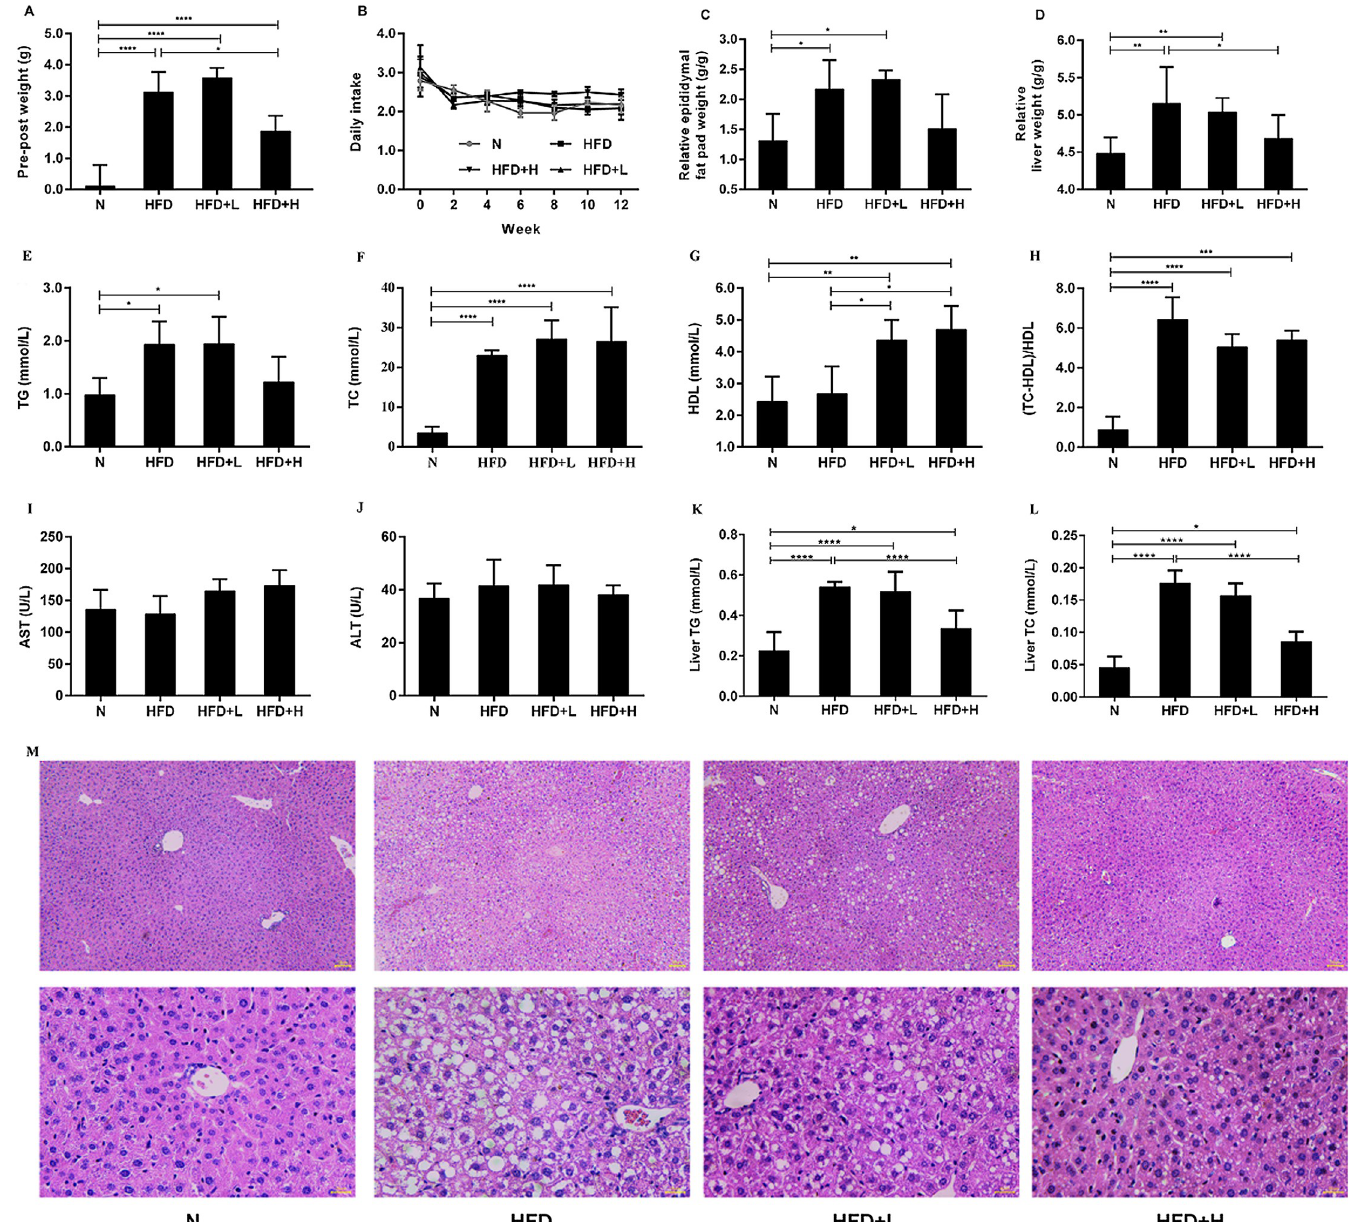
Fig 1. Effects of YNKB on physical features, biochemical features and histopathological findings of HFD-induced ApoE-/- mice. (A) The relative body weight gains; (B) The daily food intake (measured weekly); (C) The relative epididymal pad weights; (D) The relative liver weights of ApoE-/- mice; (E) TG; (F) TC; (G) HDL; (H) Atherosclerosis index; (I) AST and (J) ALT of ApoE-/- mice with YNKB supplementation; (K) Hepatic triglyceride and (L) cholesterol levels were determined. (M) Hepatic tissues were evaluated by HE staining. All photos are displayed under a 200x and 400x magnification. Data are presented as the mean ± S.D. � p < 0.05, �� p < 0.01, ��� p < 0.001, ���� p <